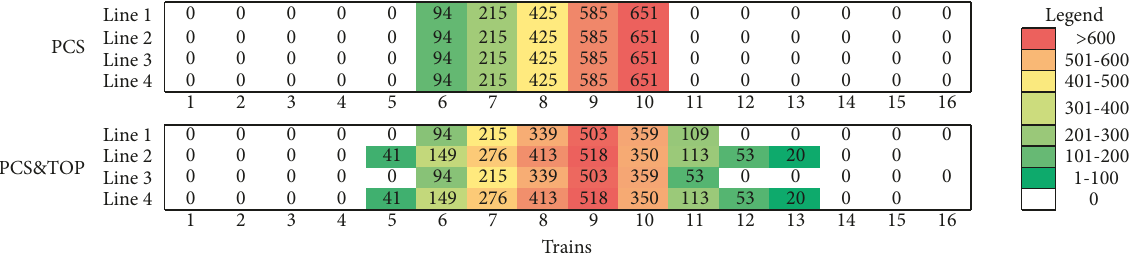
. (a) Range from 0.01 to 1000; and (b) Range from 0.1 to 2.0. 2